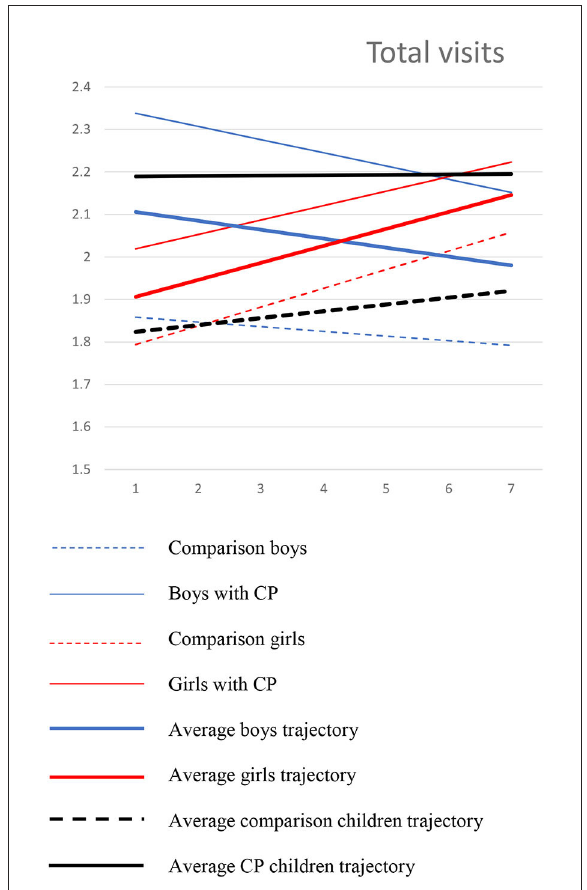
FIGURE1 Trajectories of total visits among boys and girls with and without